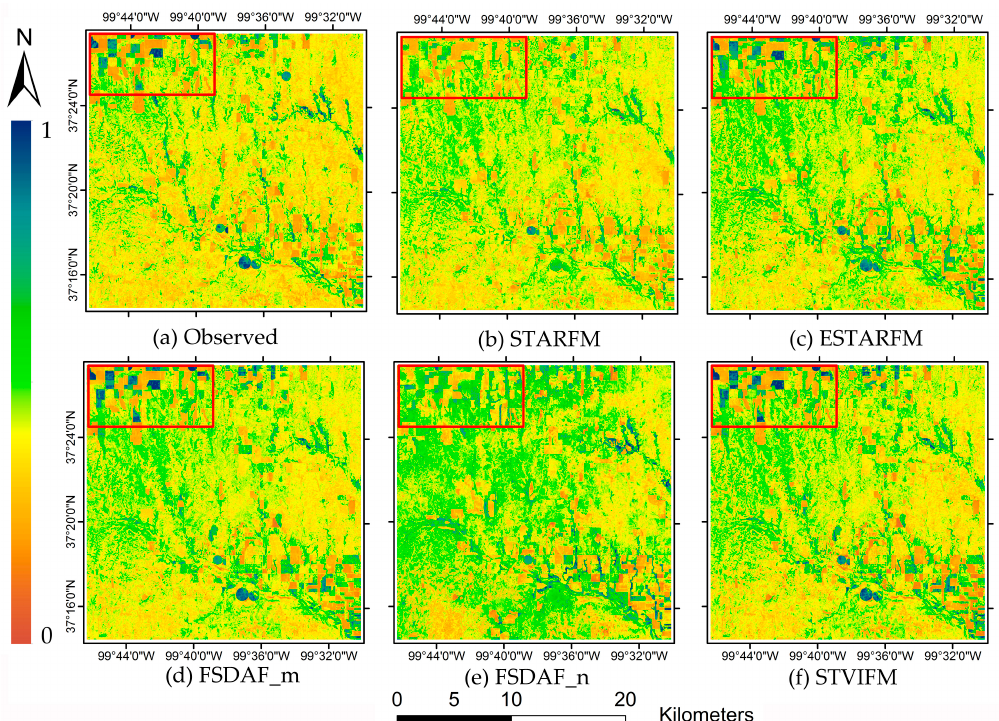
Figure 11. Comparison of the observed Landsat image ( a ); and the synthetic images based on: STARFM ( b ); ESTARFM ( c ); FSDAF ( d , e ); and STVIFM ( f ), in Kansas, U.S. Red boxes show that the harvesting of crops appeared in Landsat-8 images acquired at t n (20 June 2014) are accurately predicted in the synthetic NDVI image based on the STVIFM and ESTARFM.